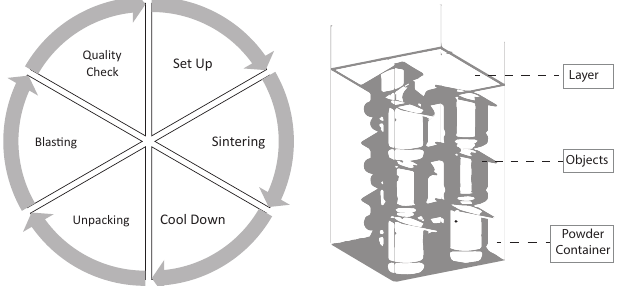
Figure 3. The additive manufacturing process includes several phases in which objects are produced from powder in a layer-wise